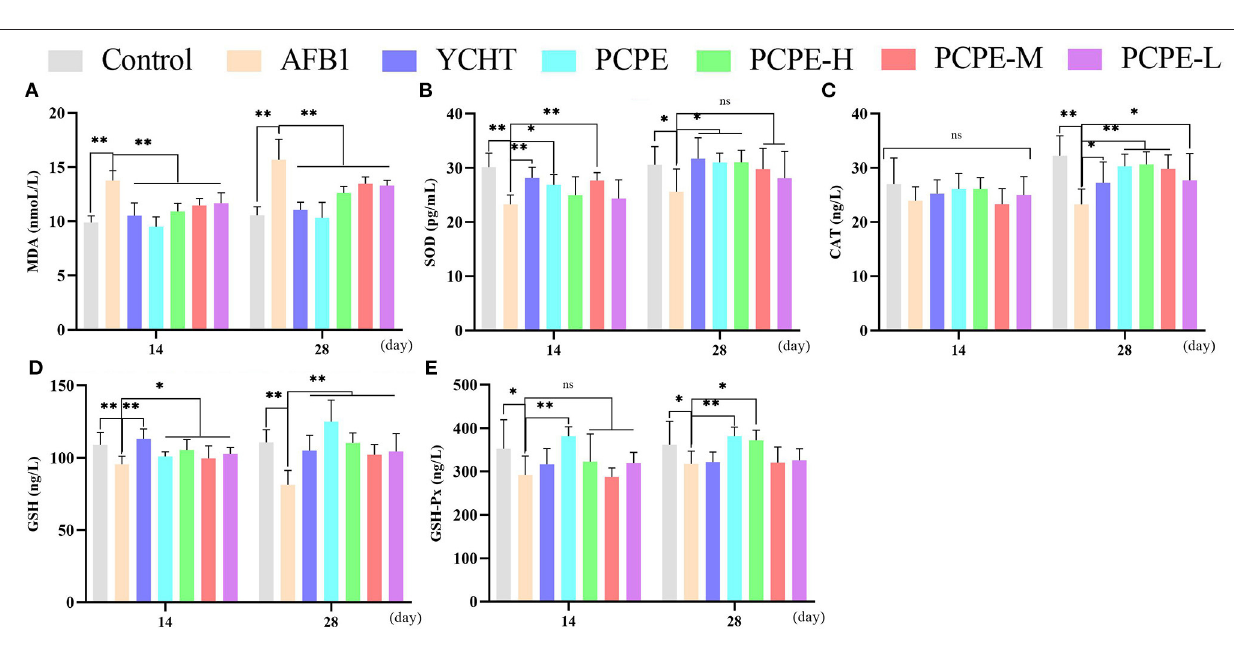
FIGURE 3 | Effect of PCPE on serum antioxidant parameters. Values are represented as mean ± SD. Mean values were significantly different (* P < 0.05; ** P < 0.01), ns, non-significant. (A) MDA (B) SOD (C) CAT (D) GSH (E)